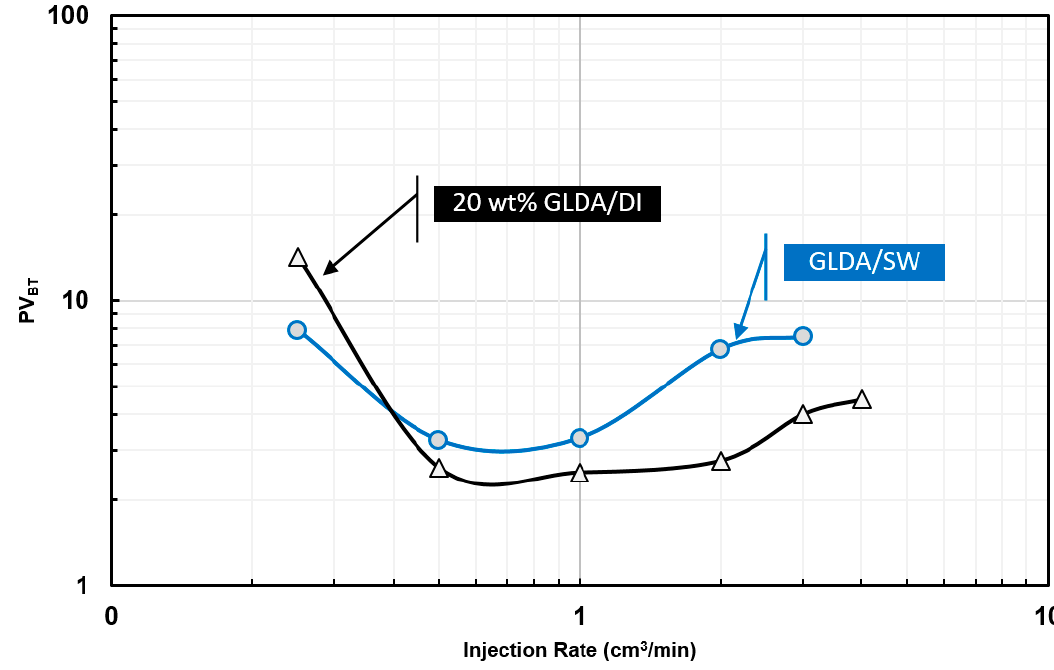
Figure 14. The breakthrough curve of 20 wt% GLDA/SW (pH 3.8) in six inches. Indiana limestone core samples at 250 °F compared to GLDA/DI at pH of 3.8 in 6.0 inches by Mahmoud et al. (2011).